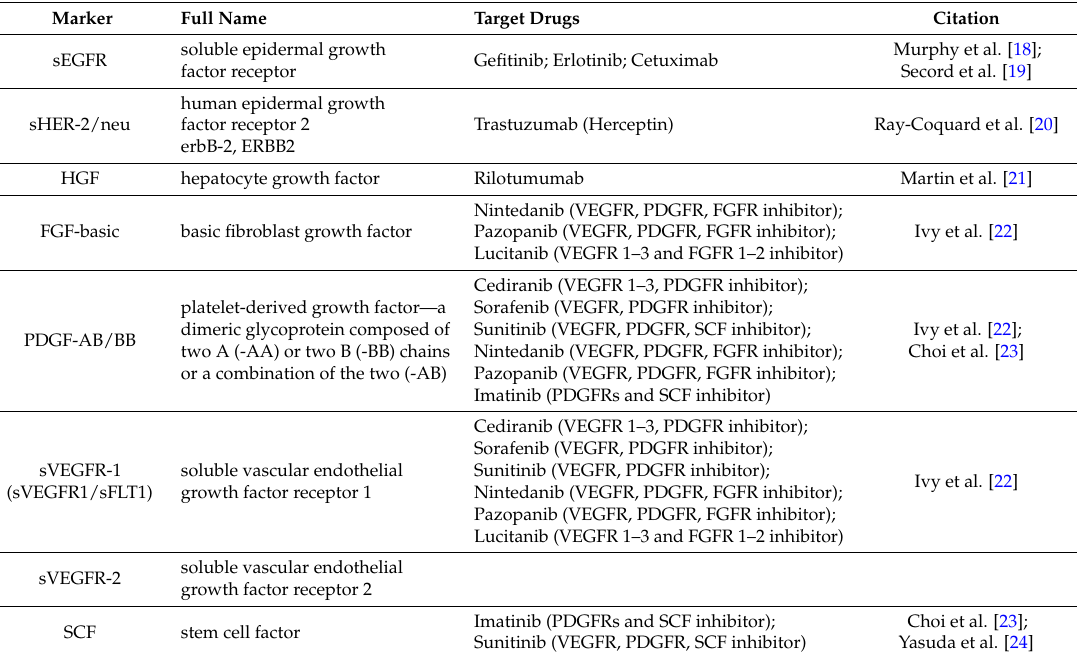
Table 3. Examples of the targeted therapies which are already under evaluation in clinical trials for eight studied